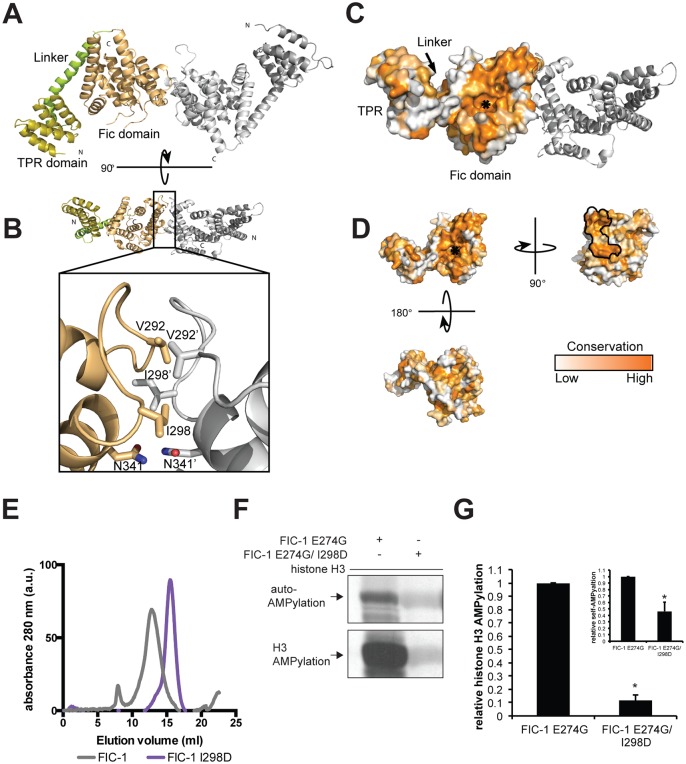
FIC-1 structure, domains and dimer interface.(A) Ribbon representation of FIC-1 dimer, with individual domains colored in a single monomer. (B) Cartoon representation of FIC-1; the dimer interface is highlighted in the inset where key side chain and backbone contacts are shown. (C) Surface representation of FIC-1 monomer and ribbon representation of a second monomer, the ATP binding site is highlighted with a white asterisk. (D) Surface representation of FIC-1 monomer; coloring is based on conservation from an alignment between Fic-domain containing proteins. Dimerization interface is outlined in black. (E) Size exclusion chromatogram showing elution profiles of FIC-1 wildtype (wt), and FIC-1 I298D. Elution volumes of standards are highlighted with arrows. (F) Monomeric FIC-1 E274G/I298D exposes reduced AMPylation activity: FIC-1 E274G or FIC-1 E274G/I298D were pre-incubated with α 33P-ATP for an hour before histone H3 was added and the mixture was incubated for another hour. Incorporation of label was assessed by SDS-PAGE and autoradiography. (G) Quantification of histone H3 and self-AMPylation (inlet). Data shown represents the average of two independent replica. * = p-value < 0.01 (t-test).